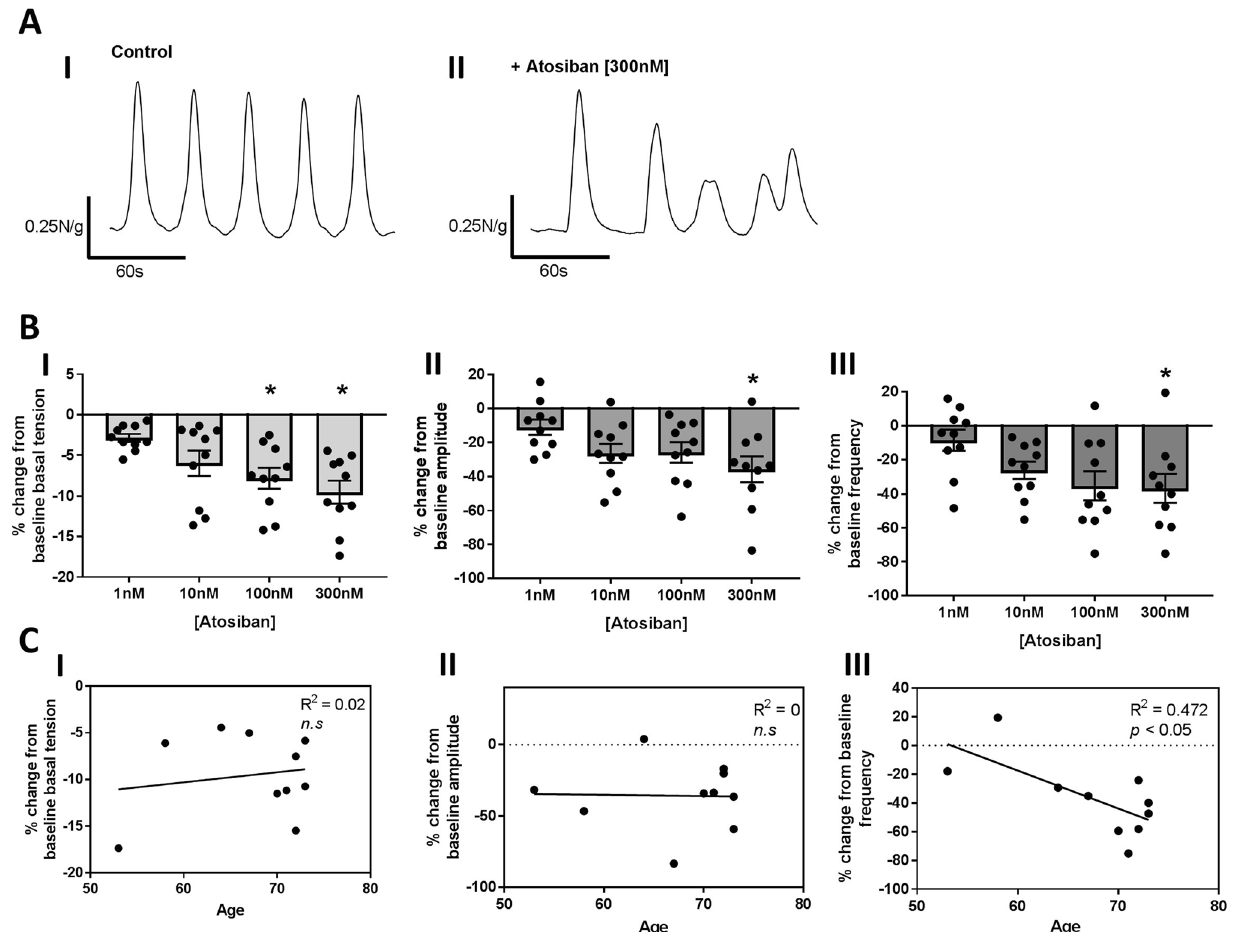
Figure 5. Application of atosiban, an OXTR antagonist, significantly reduced spontaneous contractile parameters in human prostate specimens, with reduction in frequency correlated with age. ( A ) Representative trace of spontaneous contractions (I) prior to and (II) following application of atosiban [300 nM]. ( B ) Average % change from baseline (I) basal tension, (II) amplitude, and (III) frequency of spontaneous contractions following incubation with increasing concentrations of atosiban [1, 10, 100 and 300 nM] (n = 10. paired one-way ANOVA with Dunnets multiple comparisons test, * p < 0.05, ** p < 0.01). ( C ) correlation between average % change from baseline (I) basal tension, (II) amplitude, and (III) frequency of spontaneous contractions following incubation with atosiban [300 nM] with age (n = 10, Linear Regression analysis, p < 0.05 considered